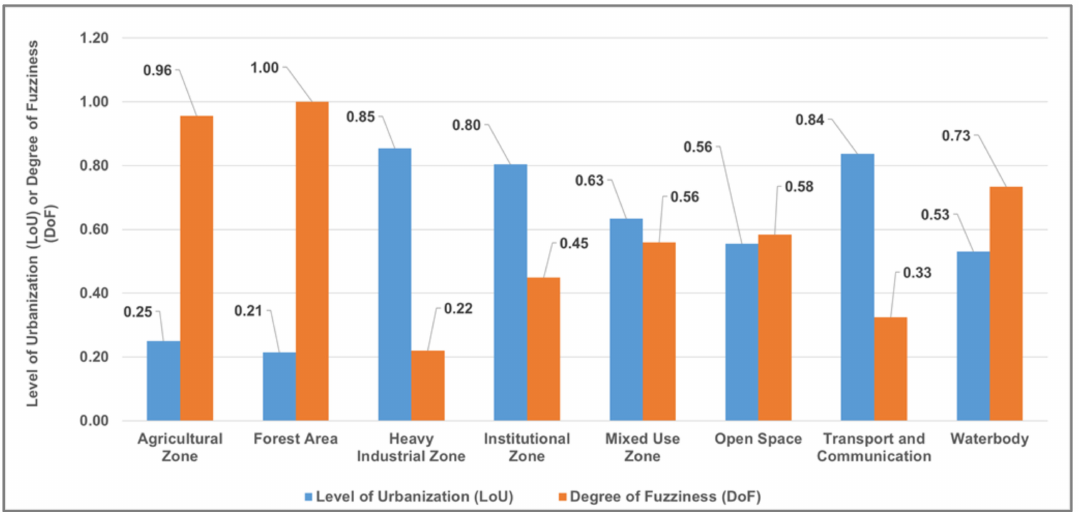
Figure 12. The level of urbanization (LoU) and degree of fuzziness (DoF) under the CRDP’s 2015–2035 prosed land use